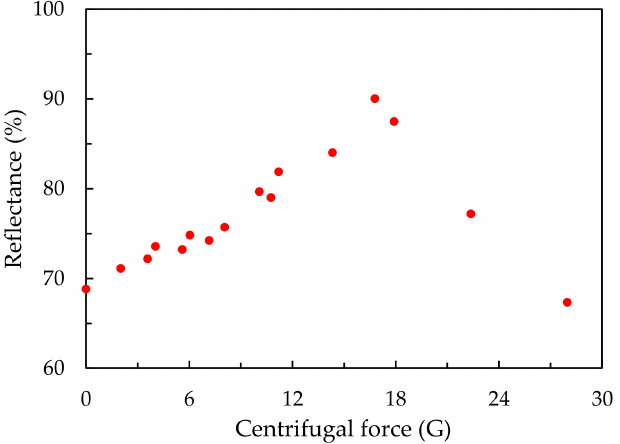
Figure 3. Reflectance values of samples stacked with a 30 wt % silica colloidal solution under different centrifugal forces.